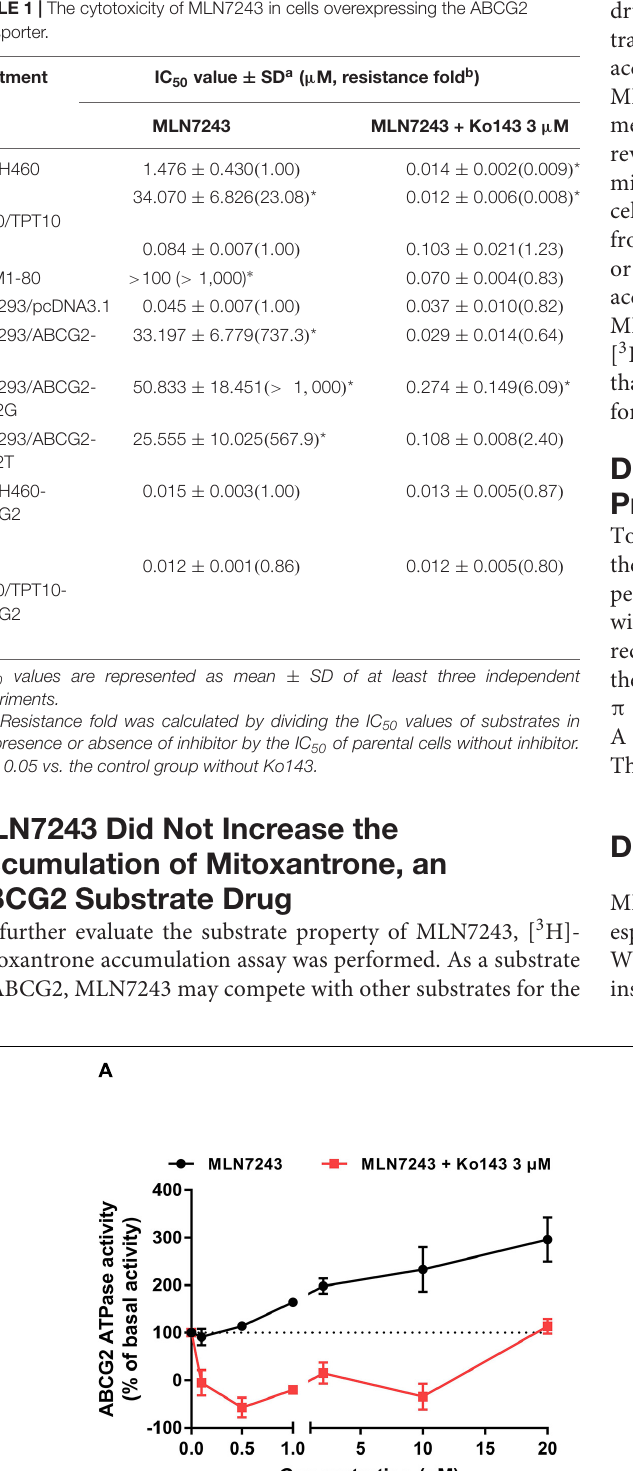
Frontiers in Cell and Developmental Biology |